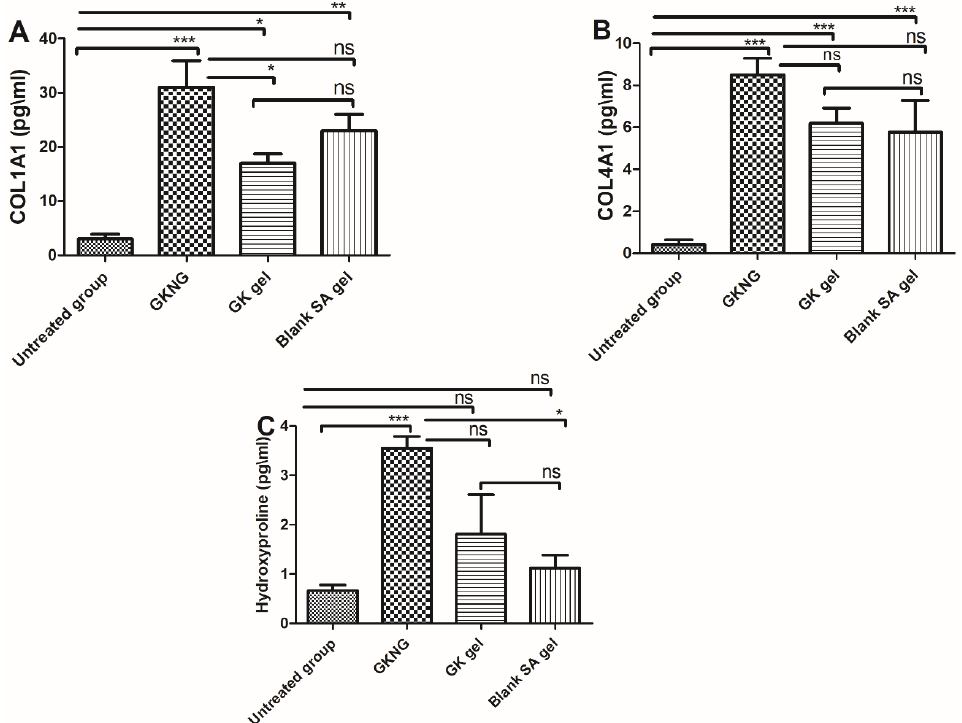
Figure 6. Effects of GKNG, GK gel, and blank SA on the fibrotic markers ( A ) CL1A1, ( B ) CL4A1, and ( C ) hydroxyproline. Values are represented as mean ± SD (n = 4). Statistical analysis was performed by one-way ANOVA followed by Tukey’s multiple comparison test. ‘***’, ‘**’, and ‘*’ refer to p < 0.001, p < 0.01, and p < 0.05 and represent significant differences between the treatment and untreated groups. ‘ns’ refers to a nonsignificant difference between the treatment groups and untreated groups.